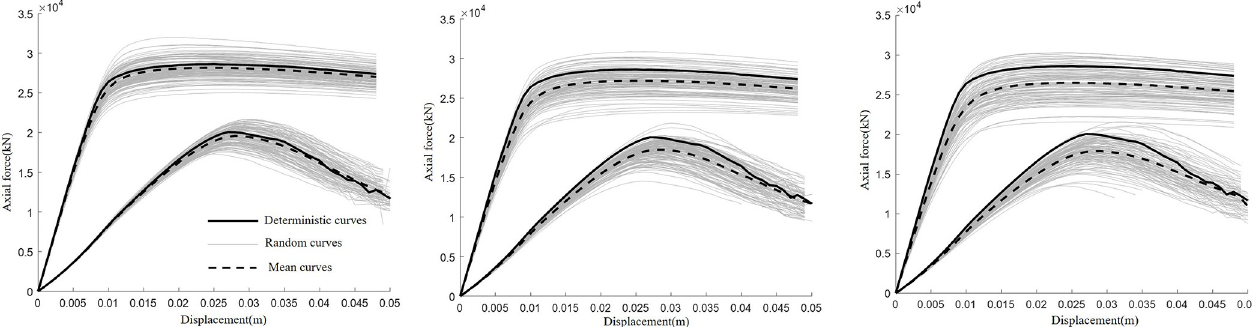
Fig 4. Effect of spatial variability. (a). Maximum deviation of column position 0 mm. (b). Maximum deviation of column position 375 mm. (c). Maximum deviation of column position 525 mm.